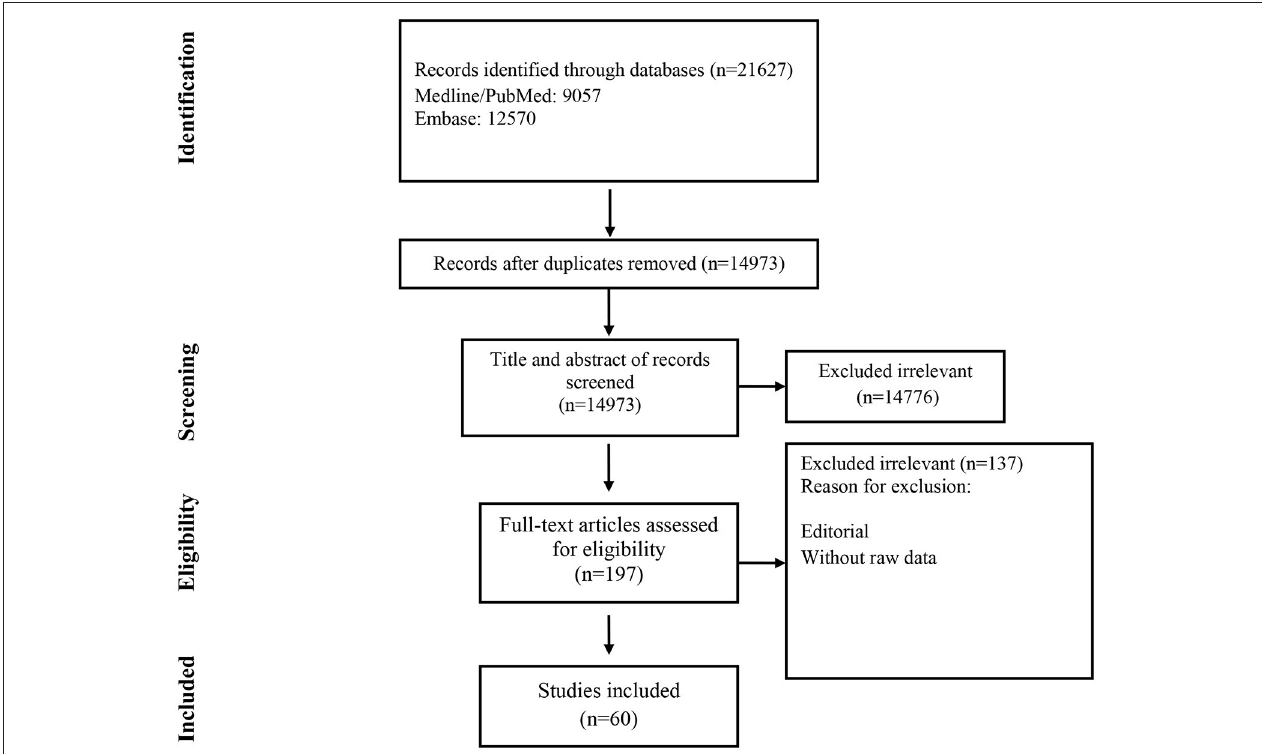
FIGURE 1 | Flow chart of study selection for inclusion in the systematic review and